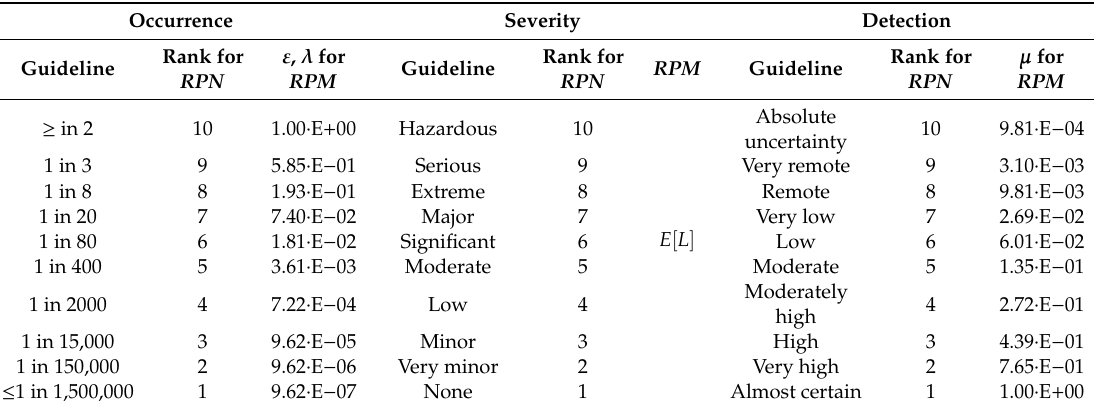
Table 2. Standardization of parameters for failure-cause occurrence rate ε , failure occurrence rate λ , and failure-cause detection rate µ : The guideline is referenced by Ford Motor Company